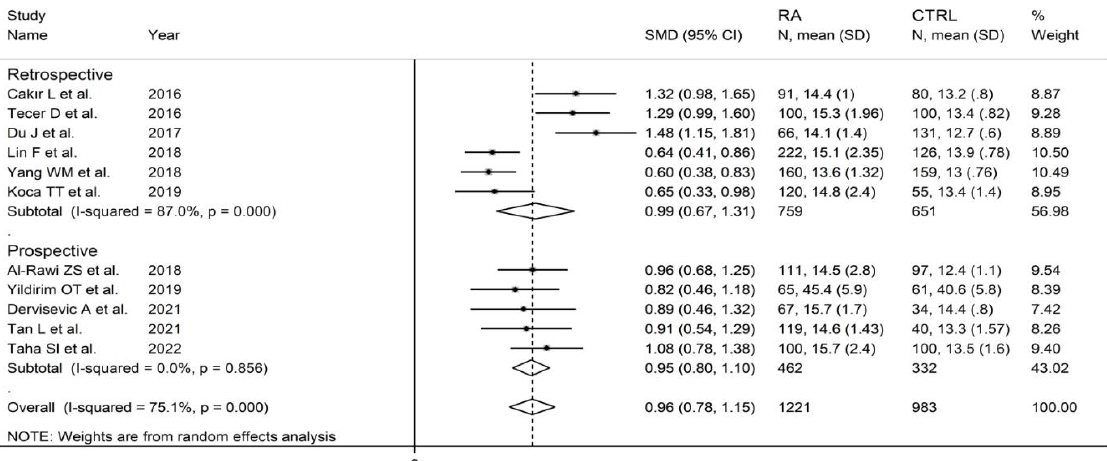
Figure 15. Forest plot of studies examining the red cell distribution width in patients with rheumatoid